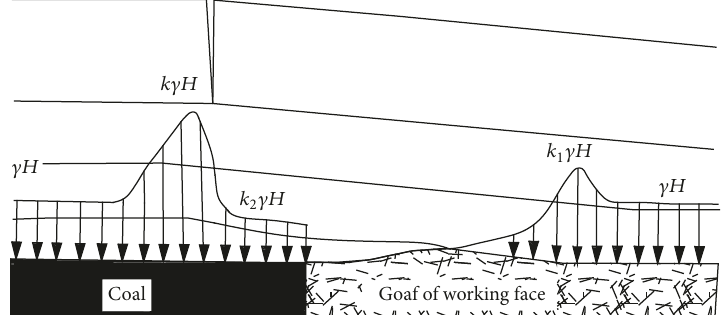
Figure 19: The model of double peaks of support pressure [22]. Table 1: Engineering example of hard roof fracturing ahead of working face. Hard roof of working